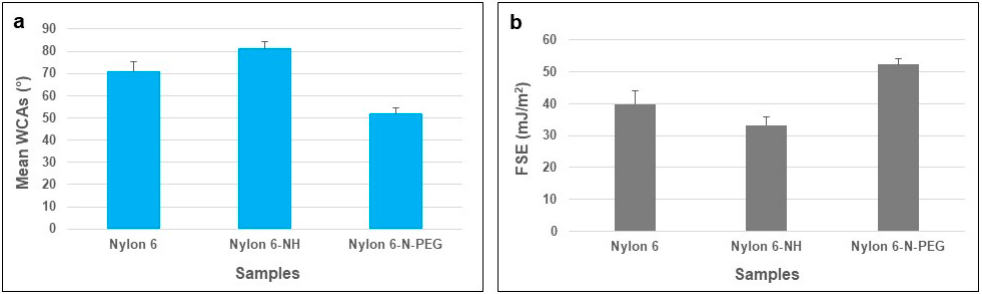
Figure 1. Mean WCA data ( a ) and FSE values ( b ), for pure and modified Nylon 6 films.